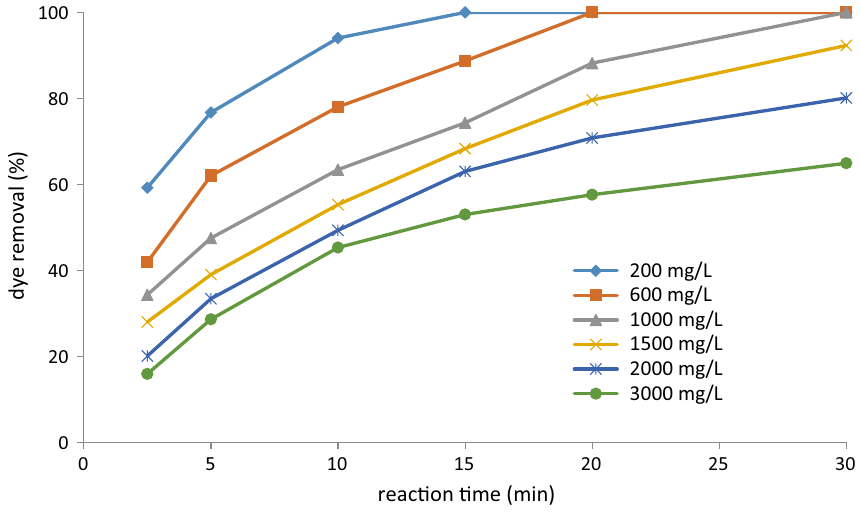
Fig. 7 Effect of MG con- centration on its degrada- tion (CD = 10 mA/cm 2 , solution pH = inherent (3), C H2O2 = 50 mg/L −1